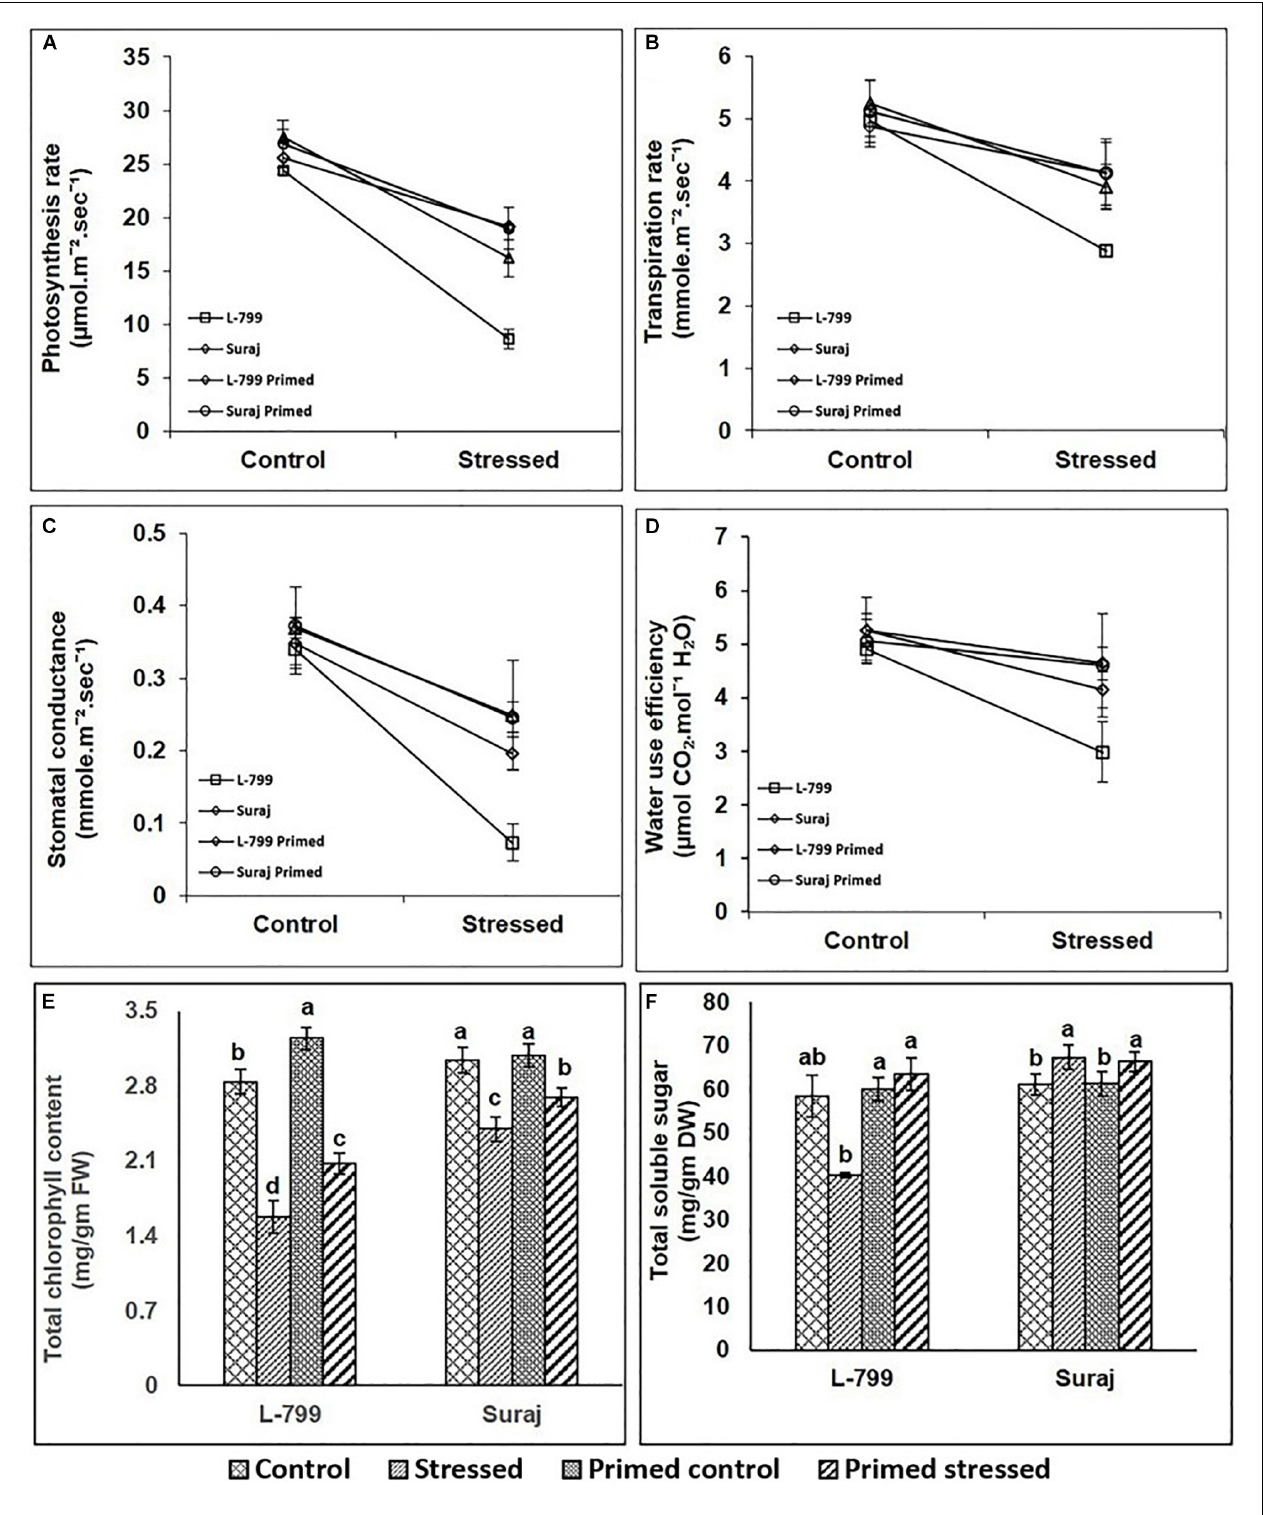
FIGURE 7 | Effect of drought stress on photosynthetic leaf gas exchanges parameters (A–D) in drought-sensitive and -tolerant varieties with or without melatonin priming. (A) Photosynthetic rate, (B) transpiration rate, (C) stomatal conductance, (D) water use efficiency, (E) chlorophyll content, and (F) total soluble sugar. Data represent mean values ± SD of minimum 3 independent experiments, with 3 replicates per treatment in each experiment. Different alphabets within the group represent significant differences among treatments according to Duncan multiple range test at P < 0.05.